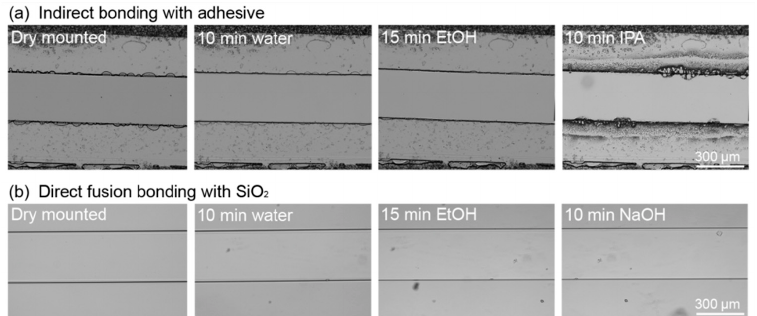
Figure 4. Chemical resistance test with cleaning solutions: ( a ) Adhesive-based bonding: solvent resistance test with a PD 955 PY bonded microfluidic chip; the chip was mounted in the periphery,